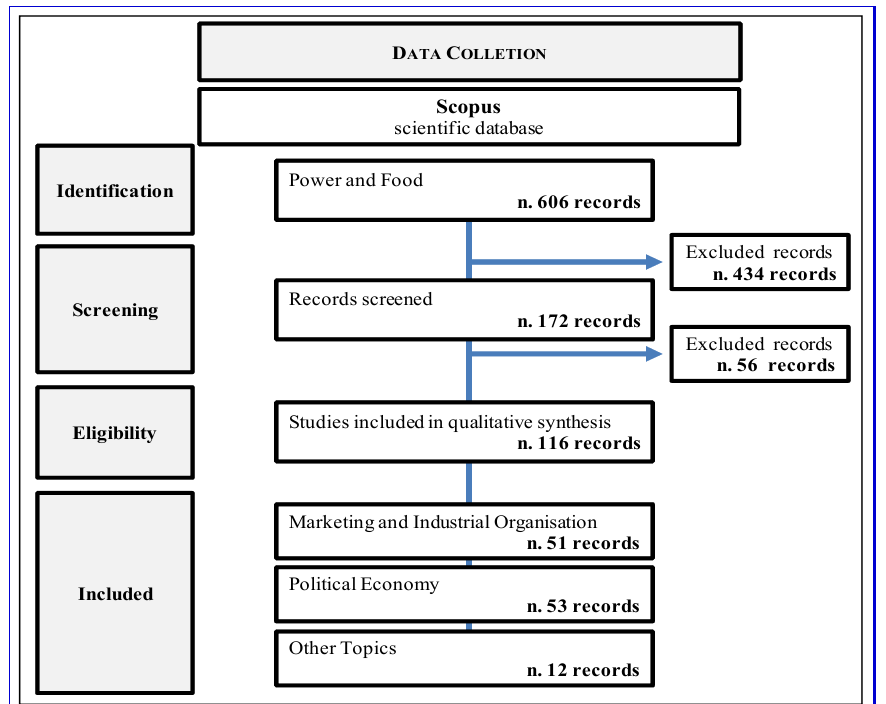
Figure 1. Methodological design of bibliometric analysis.